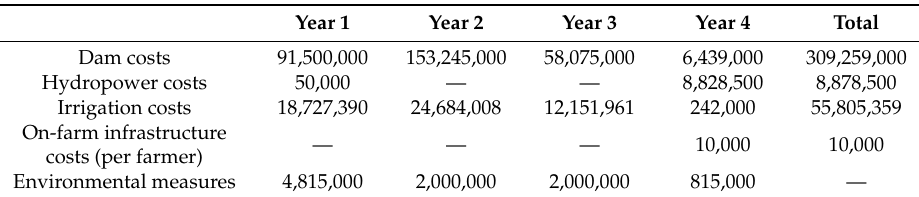
Table A6. Investment costs (USD) (at 1 USD = 1250 Iraqi